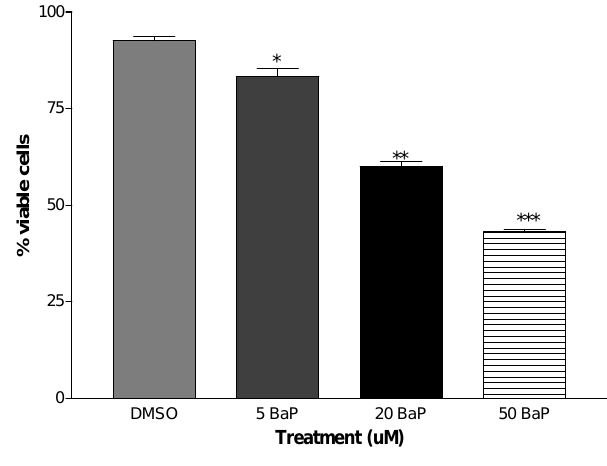
Figure 1 : Cytotoxicity of B[a]P to DU145 cells as determined by the MTT Assay. Data presented are the means ± SEMs from three experiments in triplicate. The symbol (*) indicates statistical significance at the level of p<0.05 as compared with control. The symbol (**) indicates values that are statistically significant difference from 20µM B[a]P treatment group (p<0.05). The symbol (***) indicates statistically significant difference from 50 µM B[a]P treatment a significance of p<0.05.